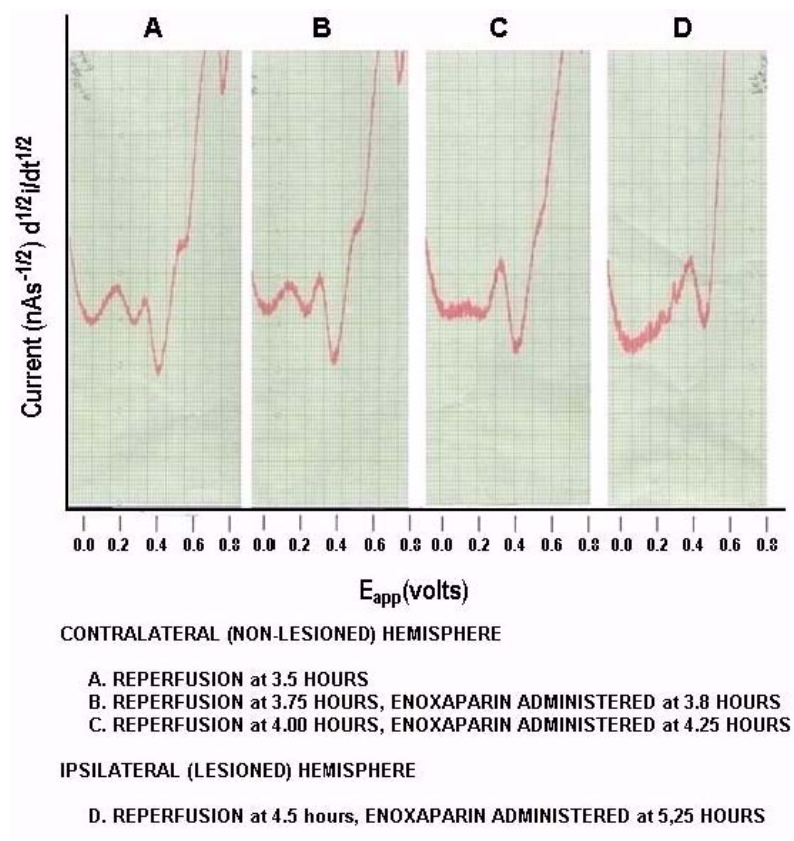
Figure 7. Original data of NMI after MCAO, enoxaparin and reperfusion; NMI from contralateral and ipsilateral